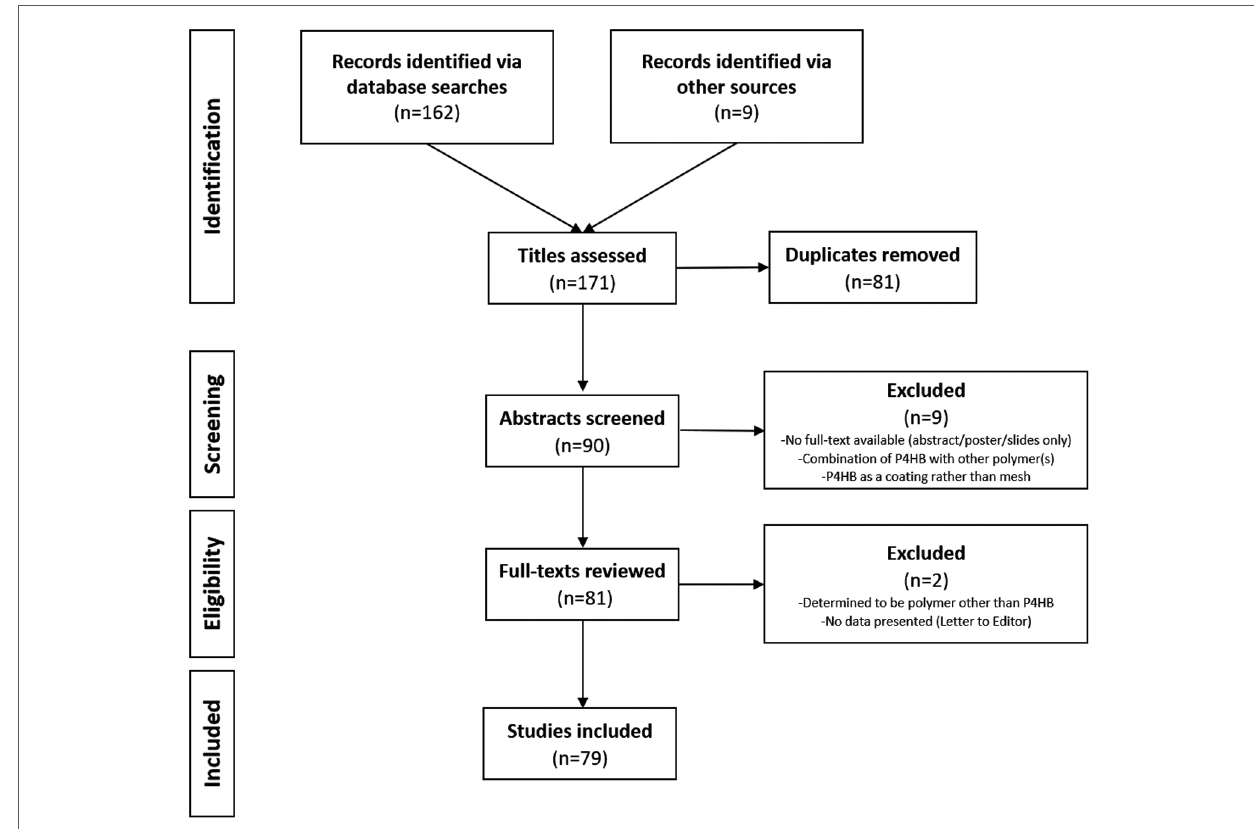
FIGURE 1 PRISMA-ScR diagram — preferred reporting items for systematic reviews and meta-analyses extension for scoping